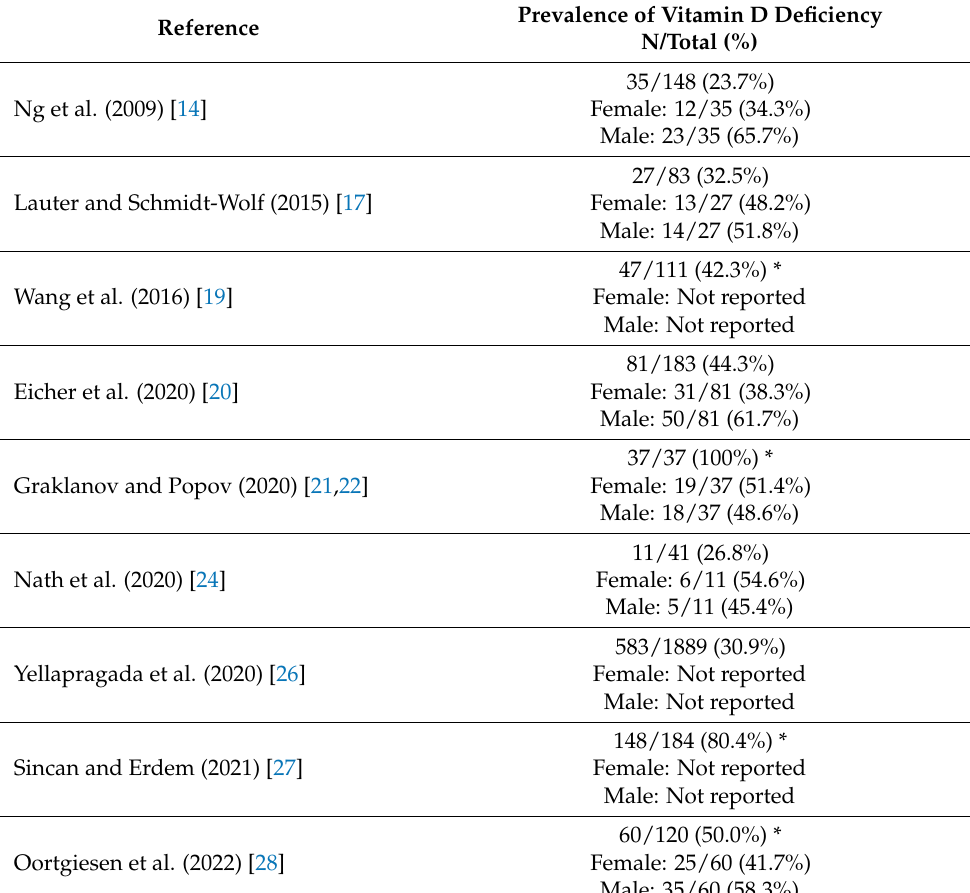
Table 3. Prevalence of vitamin D deficiency among MM study participants.